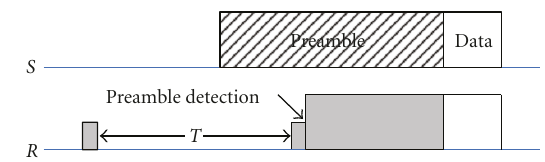
Figure 1: Low power listening- (LPL)-based on preamble sampling.